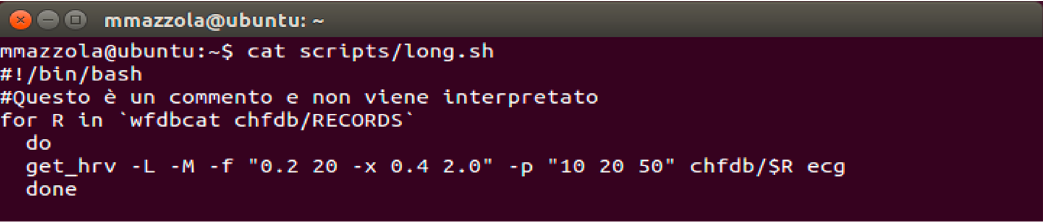
Figure 3. Script for Long-Term Analysis.